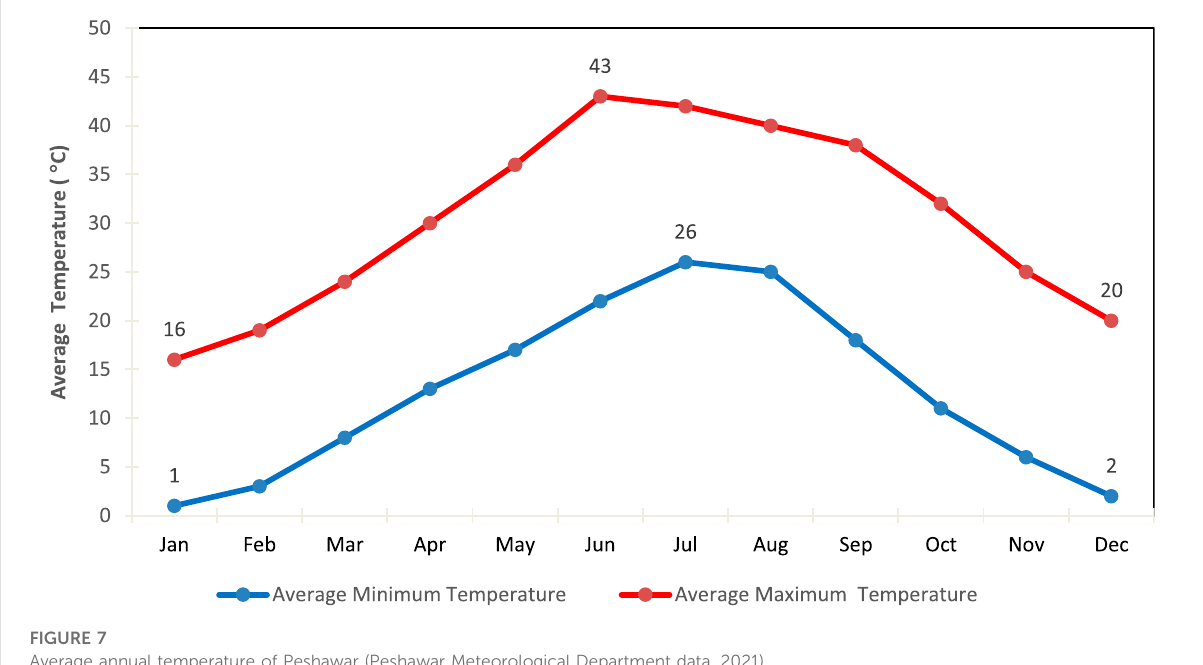
FIGURE 7 Average annual temperature of Peshawar (Peshawar Meteorological Department data,